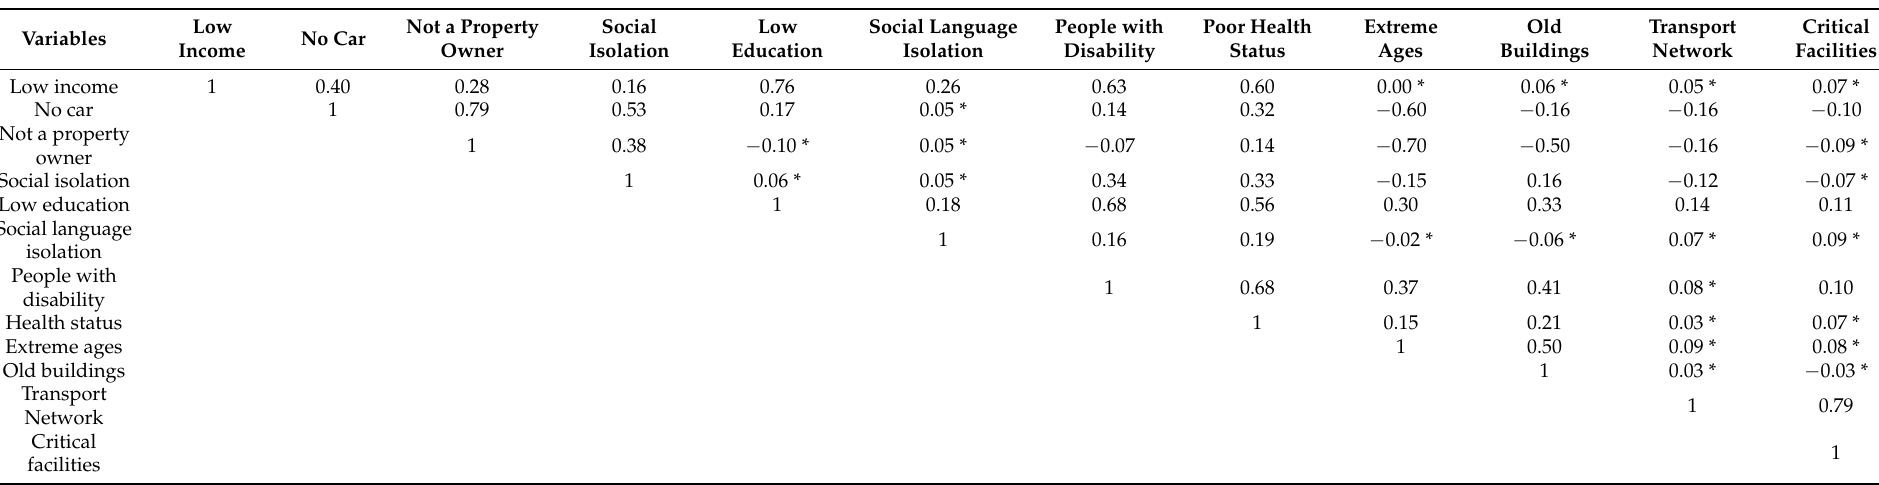
Table 3. Pearson’s correlation coefficient for final selected sensitivity and adaptive capacity variables in County Dublin. Values with asterisk show non-significant correlation with p -values >